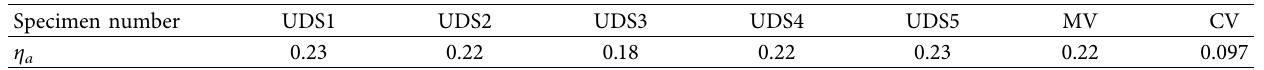
Figure 18: CFRP rod anchored by traditional bond anchor after failure. (a) Specimen after failure. (b) CFRP rod after failure. Table 5: Anchorage efficiency coefficient of traditional bond